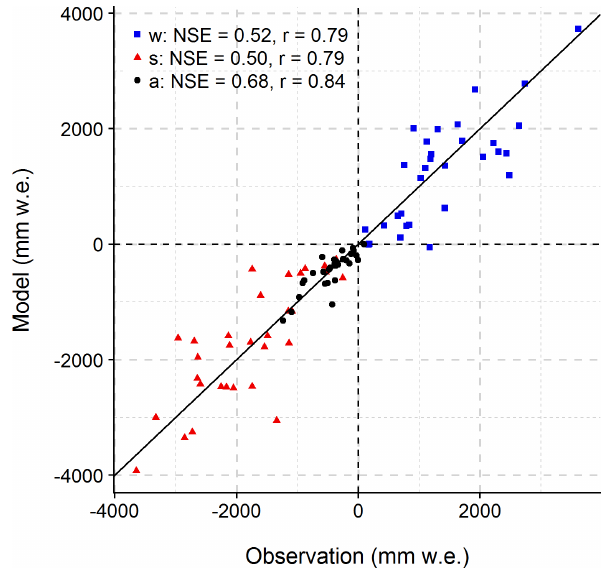
Figure 2. Correlation between observed and modelled average an- nual, winter and summer glacier mass change. Observations were taken from the collections of the World Glacier Monitoring Service (31 glaciers included). Model results were obtained with the global glacier model of Marzeion et al. (2012). Nash–Sutcliffe efficiency (NSE) and correlation coefficient ( r ) values correspond to average annual (a), winter (w) and summer (s) mass changes. Millimetres of water equivalent (mmw.e.) are relative to glacier